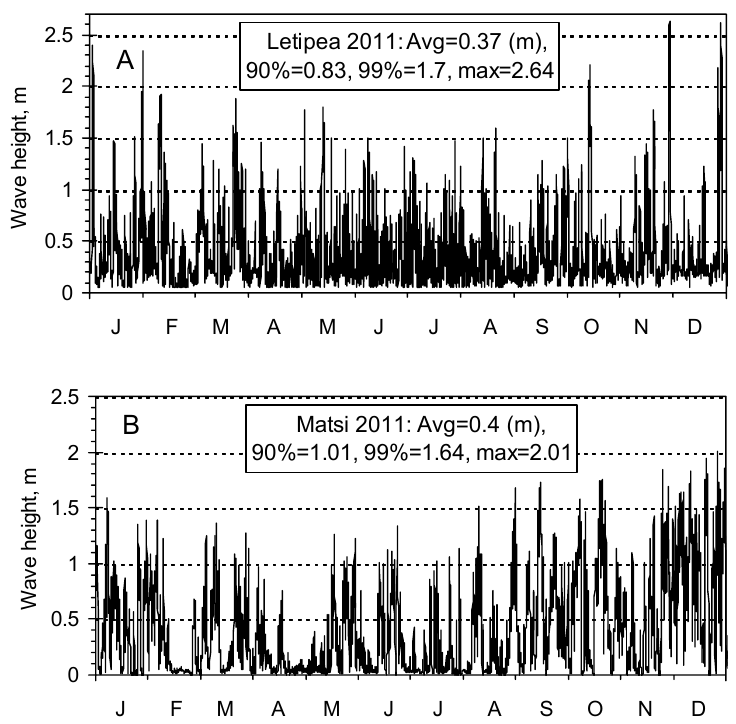
Fig. 5. Modelled hourly wave heights at the Letipea Peninsula and off the Matsi coast in